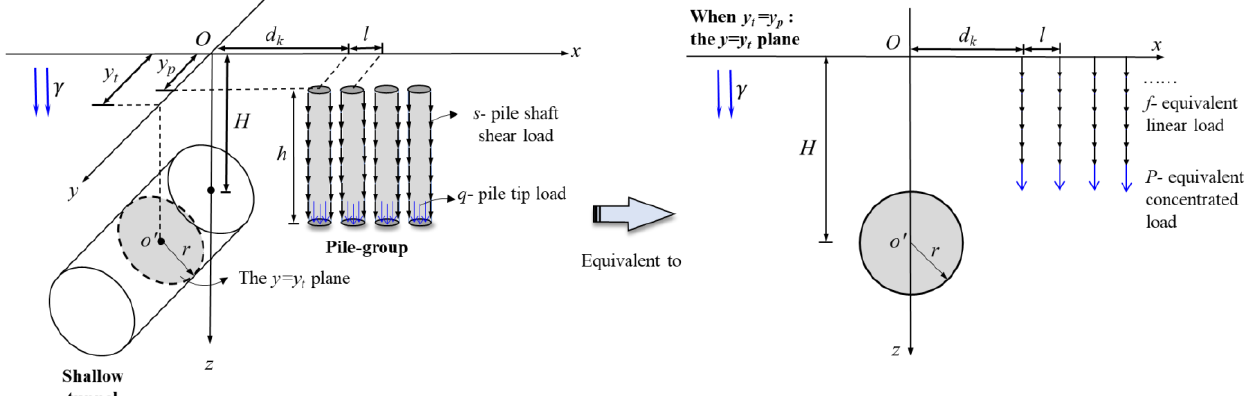
Figure 1. Mechanical analysis model of shallow tunnel adjacent to pile group.